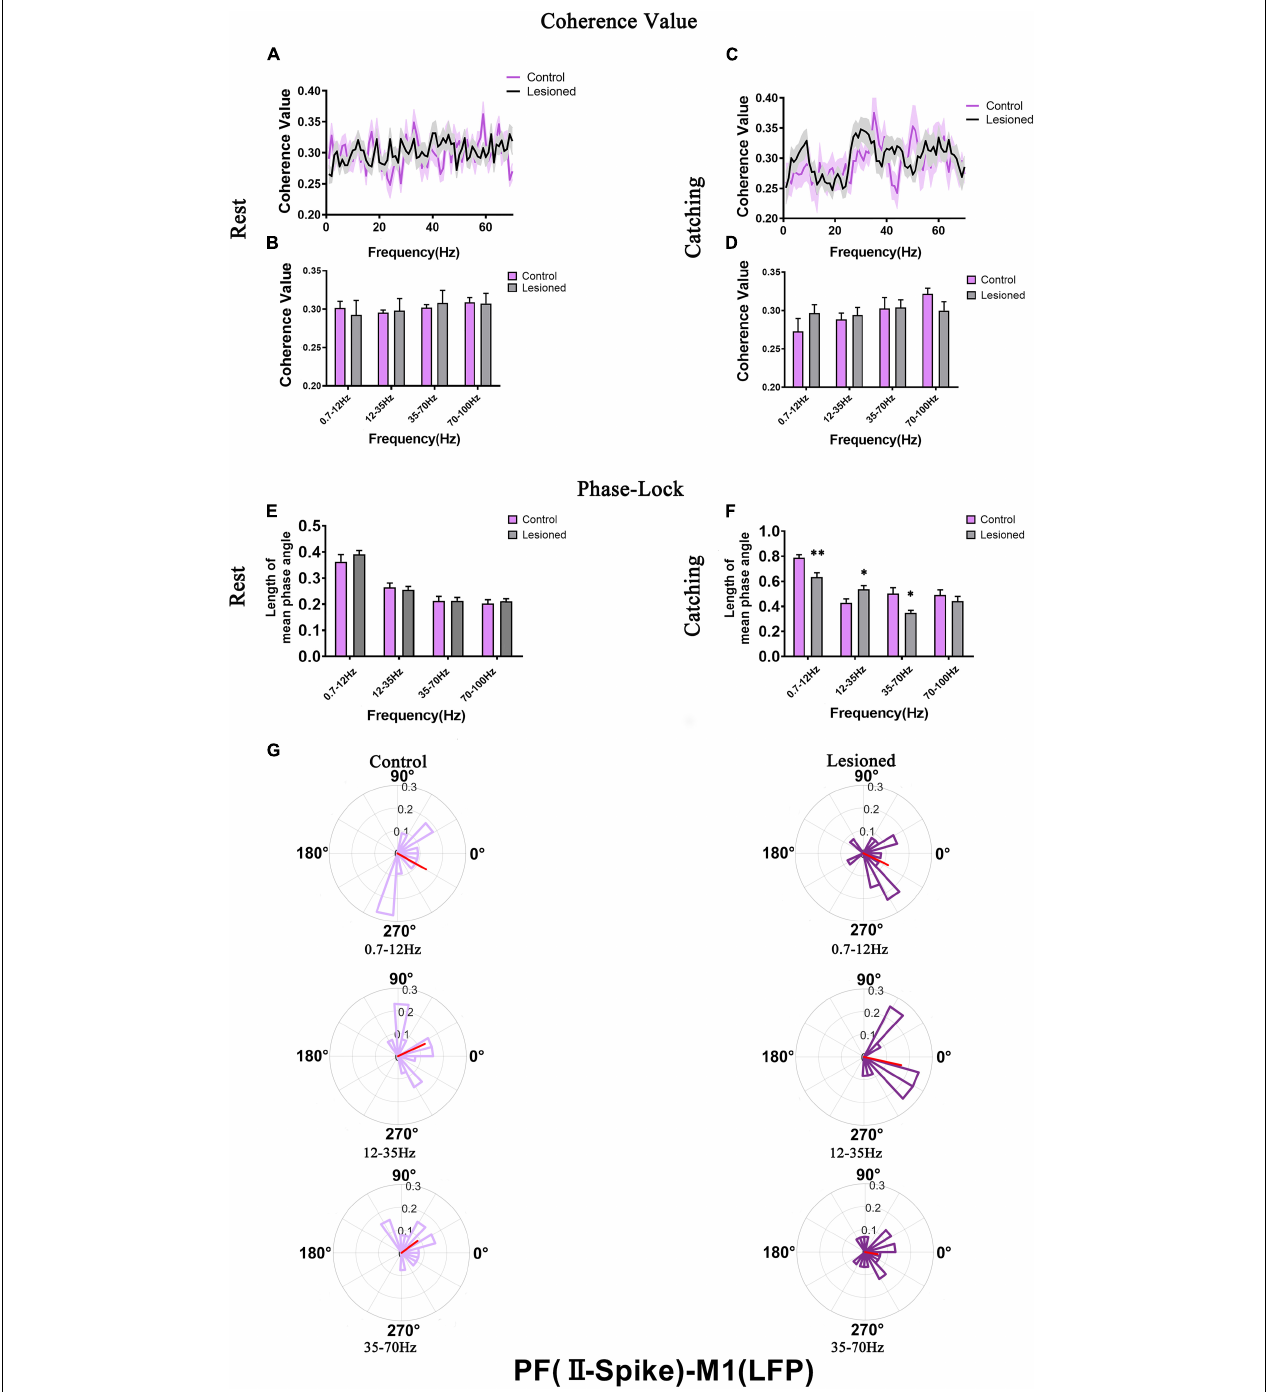
FIGURE 8 | Coherence values and phase-lock of PF-II with respect to M1-LFPs in the control rats and the DA lesioned rats. Coherence values between PF-II ( n = 19 neurons from 14 lesioned rats, and n = 30 neurons from 13 control rats) and M1-LFP have no alterations during (A,B) rest and (C,D) catching movement states. During the resting epoch, PF-II neurons in the lesioned rats did not significantly change in the length of mean phase angle compared to that of neurons in the control rats (E) . During catching movements, the length of mean phase angle was significantly lower in the ranges of 0.7–12 and 35–70 Hz in the lesioned rats (dark purple) compared to the control rats (light purple, but was significantly increased at 12–35 Hz (F,G) . Data are expressed as the mean ± SEMs ( ∗ p < 0.05, ∗∗ p < 0.01).